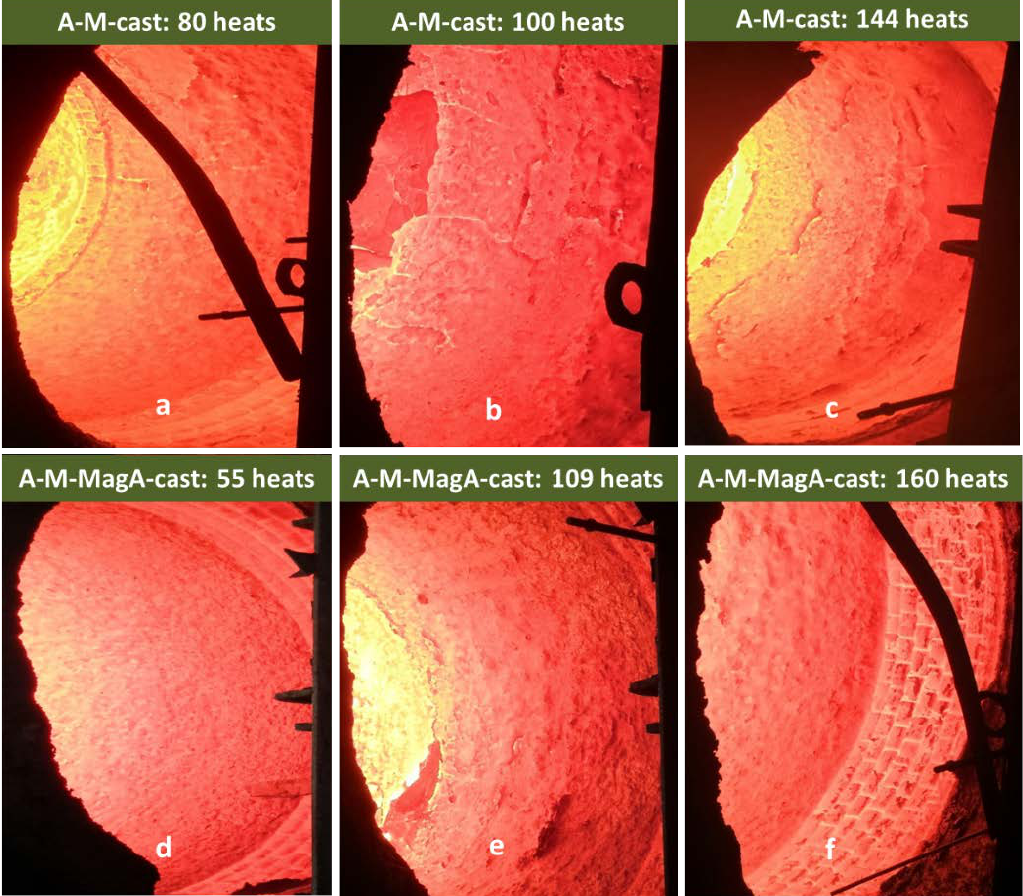
Figure 14. Steel ladle lining with alumina magnesia castable (A-M-cast) after 80 ( a ), 100 ( b ), and 144 heats ( c ) in comparison to the ladle lining with alumina magnesia castable containing 8% MagA (A-M-MagA-cast) after 55 ( d ), 109 ( e ), and 160 heats ( f ).